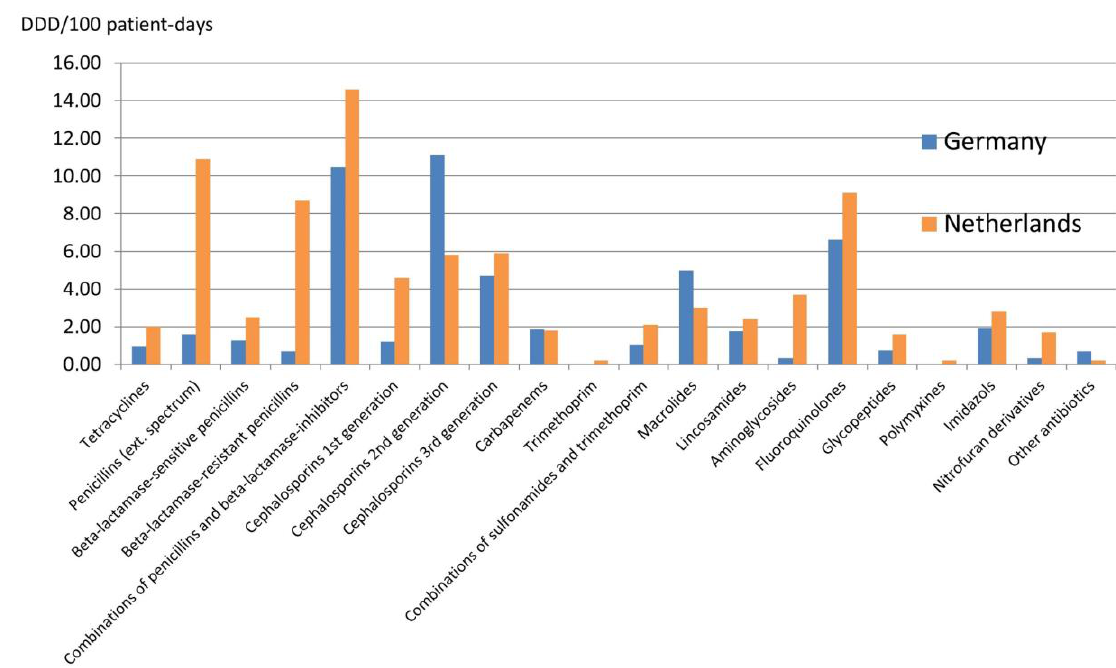
Figure 3. Antibiotic use in defined daily doses (DDD) per 100 patient-days for antibiotics belonging to the J01 category according to the ATCC classification system [8].